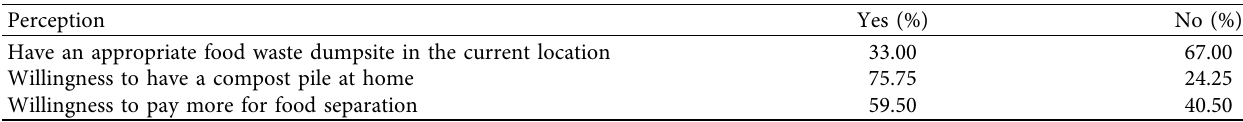
Table 2: Perception of respondents on having an appropriate food waste dumpsite in the current location, having a compost pile at home, and paying more for food separation.